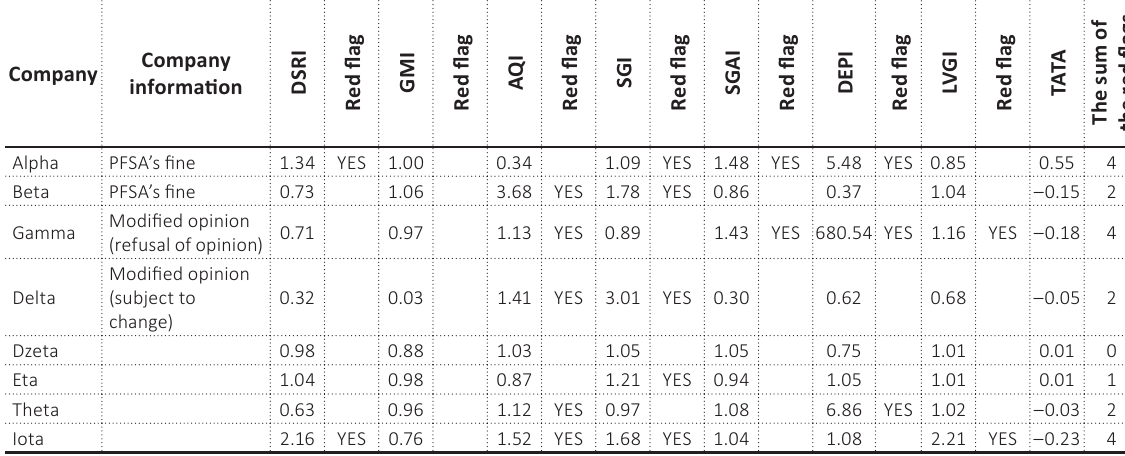
Table 4. Number of “red flags” in companies tested with the Beneish model